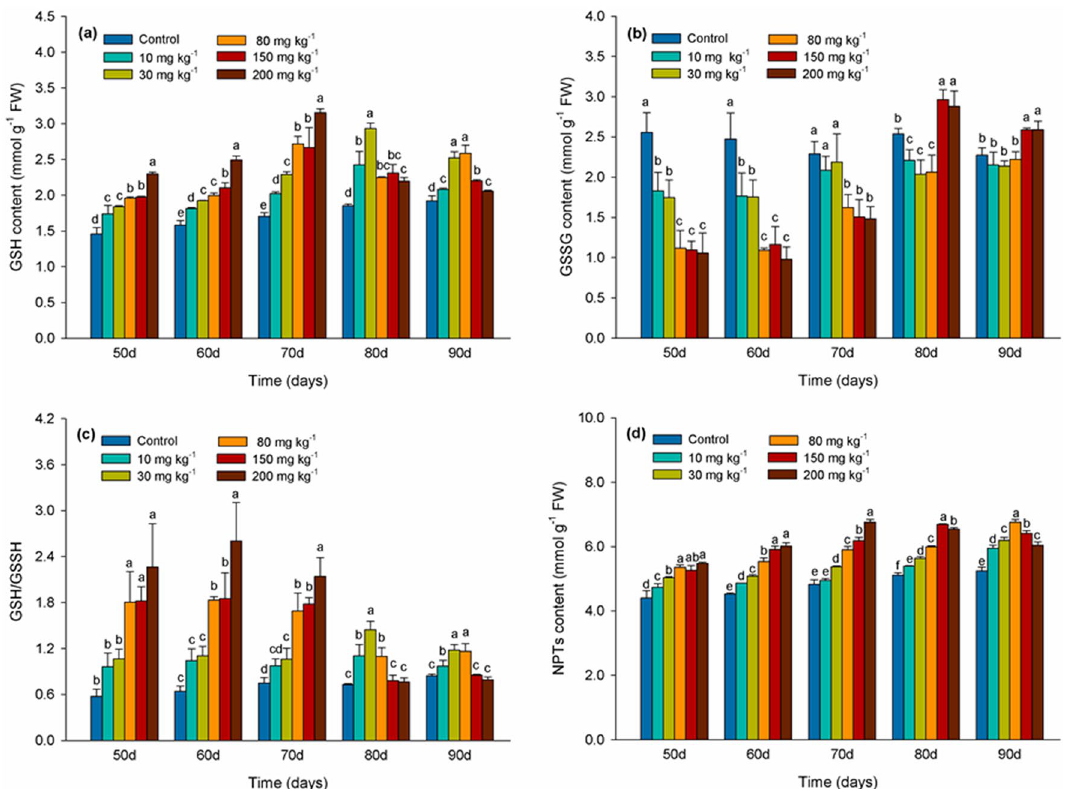
Figure 3. GSH (reduced glutathione) ( a ), GSSG (oxidized glutathione) ( b ), GSH/GSSG ( c ) and NPTs (non- protein thiols) ( d ) in leaves of Lonicera japonica Thunb. cuttings exposed to different concentrations of cadmium. Different letters indicate a significant difference ( P < 0.05) based on Duncan’s multiple range test at 5% level. Values are the mean ± SD (n =